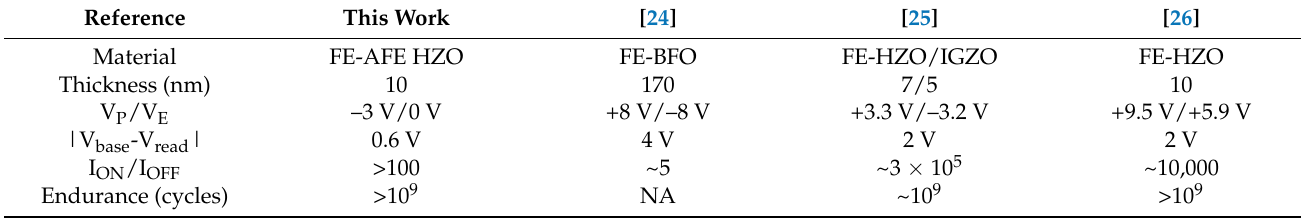
Figure 10. The endurance characteristics of the diodes for ( a ) [Zr] = 50% under bipolar operations, and ( b ) [Zr] = 75% and ( c ) [Zr] = 90% under unipolar operations. Unipolar operations for the AFE diodes show superior endurance, especially the [Zr] = 75%, which exhibits no obvious degradation up to 10 9 cycles. The FE diode with bipolar switching degraded significantly after 10 7 cycles of AC stress. Table 1. Benchmark of the comparison with prior arts for resistive ferroelectric diodes, perovskite FE-diodes for Refs. [24–26]. The unipolar operation and low V P/E are advantages of the proposed FE-AFE diode and result in high switch endurance of >10 9 cycles.